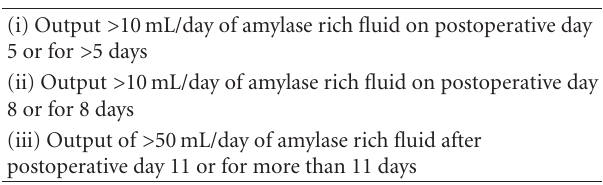
Table 1: The di ff erent components of previously used definitions of pancreatic fistula prior to the new grading System by the inter- national study group for pancreatic fistula (ISGPF) (presented in Table